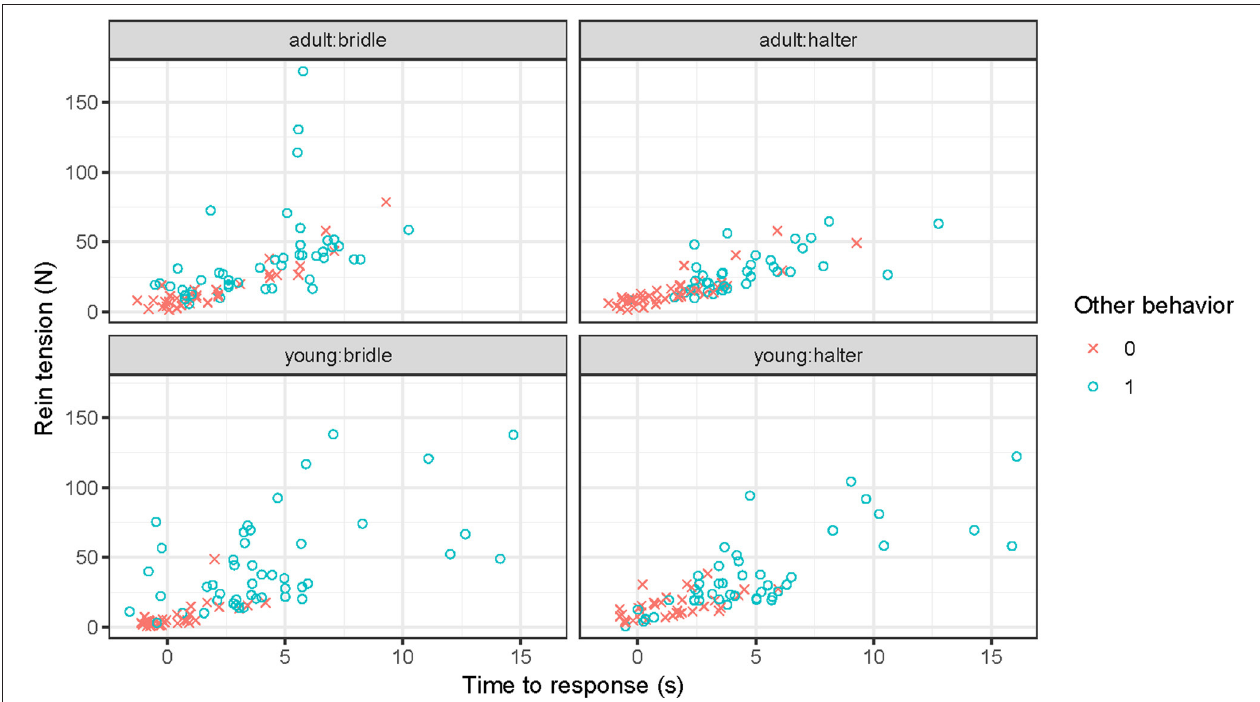
FIGURE 2 | Response latency plotted against maximum rein tension (sum of left and right rein) for bridle and halter for young and adult horses. Color and shape by presence/absence of behaviors other than backing. Data include 20 horses, backing in response to a rein tension signal, each performing eight repetitions with a bridle and eight repetitions with a halter, yielding 320 rein tension signals in total. Each dot represents one of the rein tension signals for one horse. Note that the x-axis starts before zero, as some horses responded already while the handler was picking up the reins. Behaviors included are: Looking at something, investigating, turning away, turning toward the handler, head upward, head downward, head forward, head backward, head toss, biting on the bit, and open